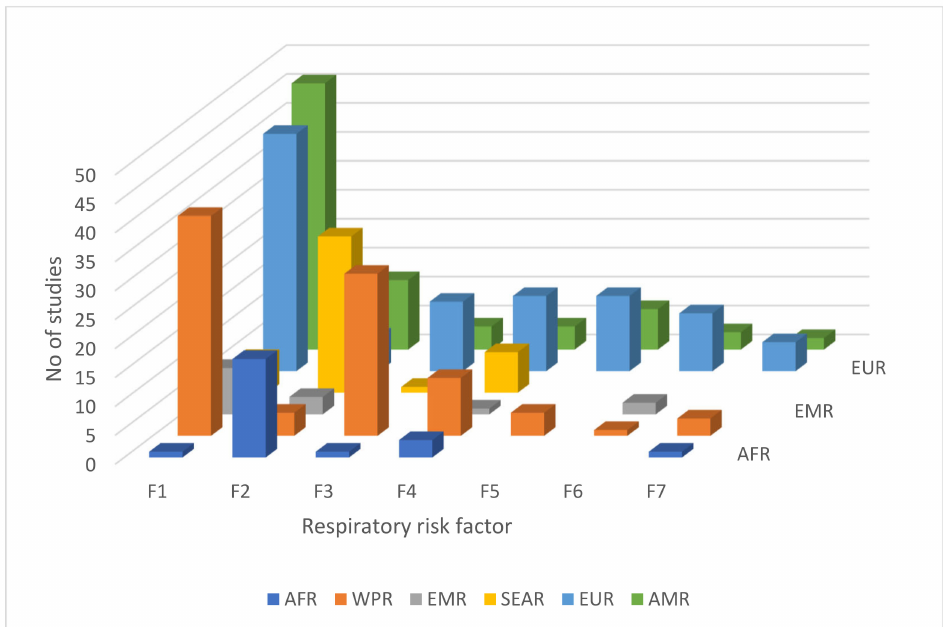
Figure 8. Distribution of respiratory risk factors across geographical regions. Note: AMR—Region of the Americas, EUR—European Region, WPR—Western Pacific Region, EMR—Eastern Mediterranean Region, SEAR—South-East Asia Region, AFR—African Region. F1—Living close to city areas, main roads, highways or industrial areas, F2—Exposure to solid fuel, F3—Meteorological factors, F4— Exposure to ETS, F5—Moisture or mould damage, F6—Exposure to radon, F7—Exposure to indoor asbestos